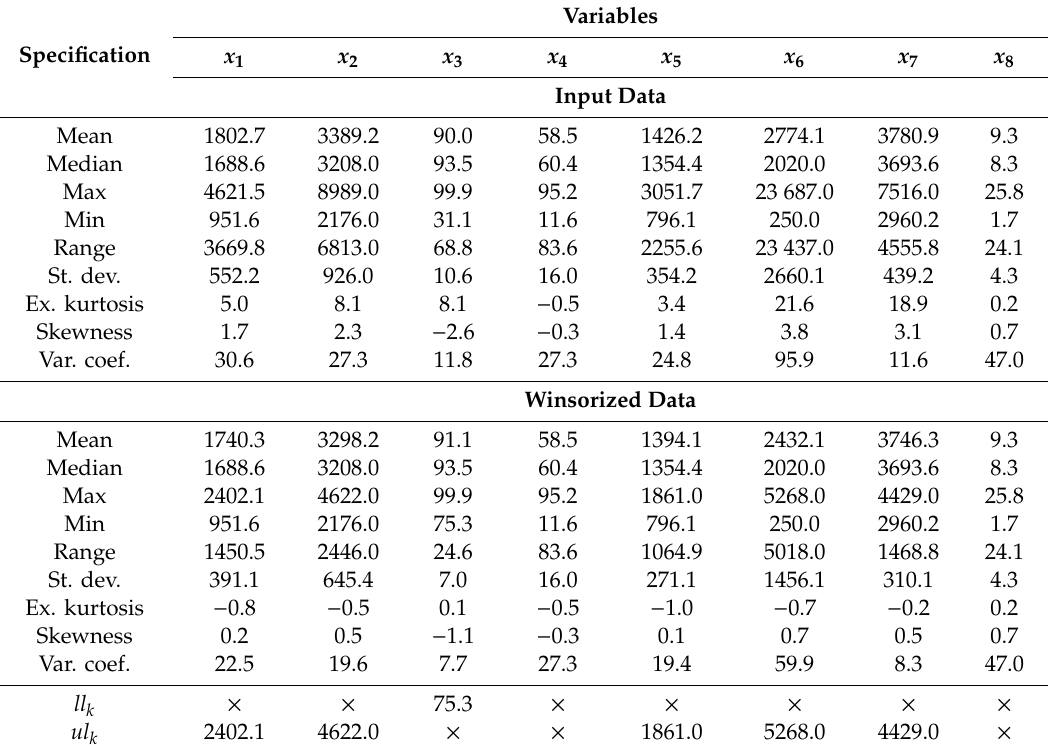
Table 2. Descriptive statistics and threshold values of the variables of LAUs at the national level.